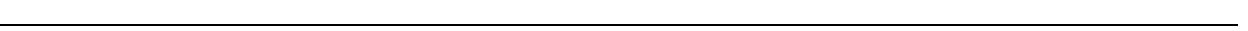
Fig. 6 Coalescence-based inference of demographic history of cattle using MSMC and ∂ a ∂ i. a Population size history inference of Bos taurus (BTA) and Bos indicus (BIN) lineages based on four haplotypes each from high-coverage European taurine (Hereford), Eurasian taurine (Gelbvieh), East Asian taurine (Tibetan), Chinese indicine (Wannan) and Indian indicine (Hariana and Sahiwal) individuals. The large grey-shaded boxes illustrate the Early Holocene Optimum, the last glacial maximum (LGM), and the second Pleistocene Glacial Period. b Inferred relative cross-coalescence rates between pairs of populations over time based on four haplotypes each from Hereford, Gelbvieh, Tibetan, Wannan and Indian breeds (Hariana and Sahiwal). The x -axis shows time and the y -axis a measure of similarity for each pair of compared populations. c ∂ a ∂ i result showing the divergence time of Chinese indicine and relative effective population size. The fi gures at the arrows indicate the average number of migrants per generation between Chinese indicine and Indian indicine